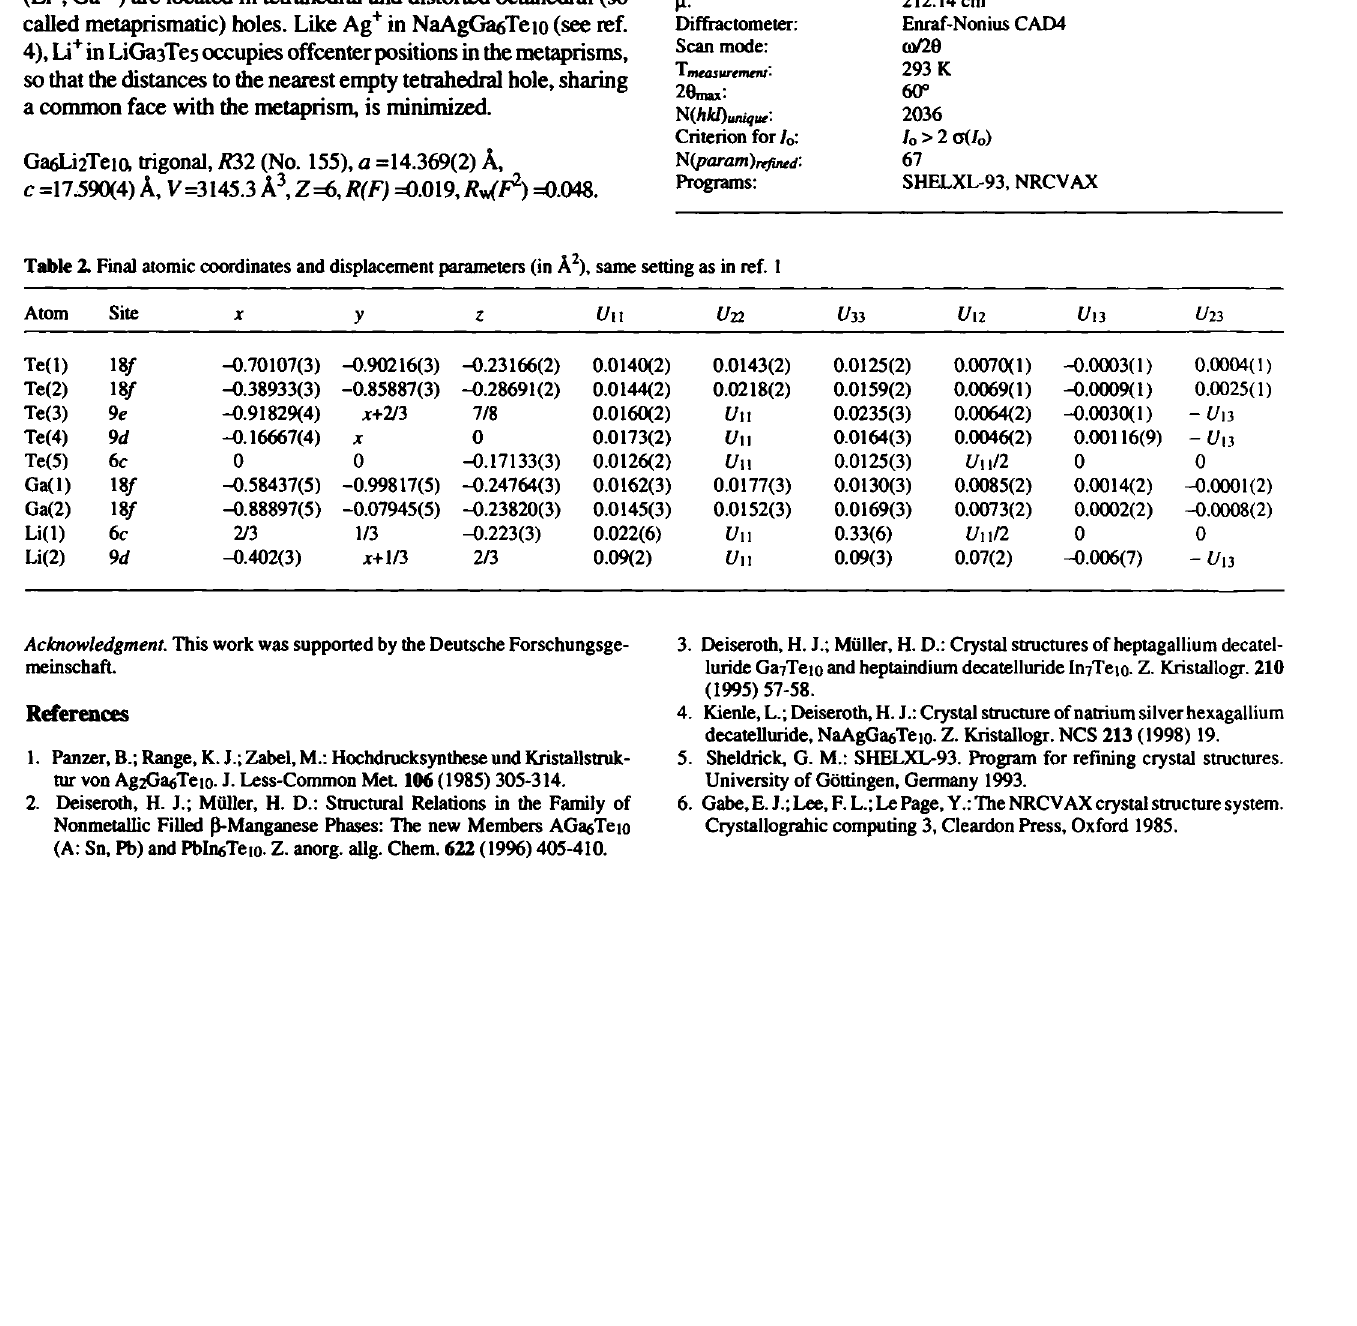
Table 1. Parameters used for the X-ray data collection Crystal: